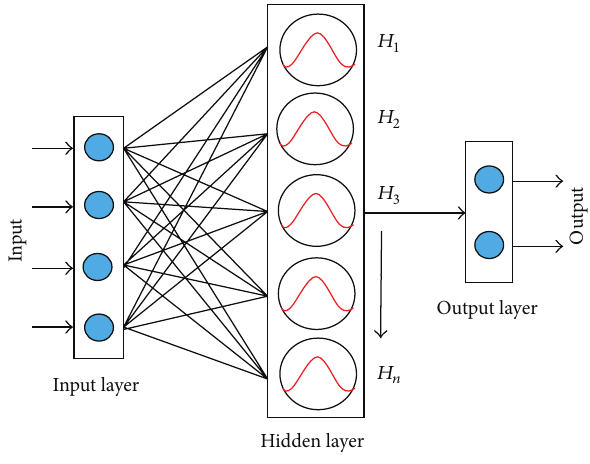
Figure 6: Structure of RBF neural network.